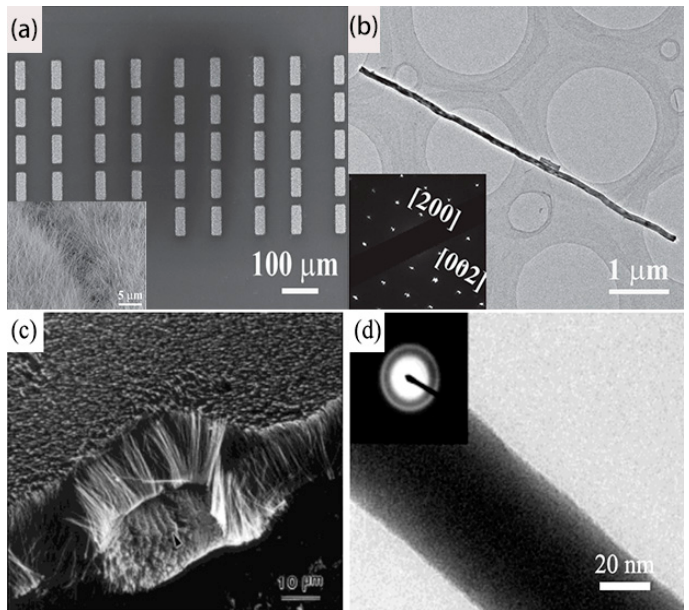
Figure 2. ( a , b ) Typical low-magnification and high-magnification SEM images of the PrB 6